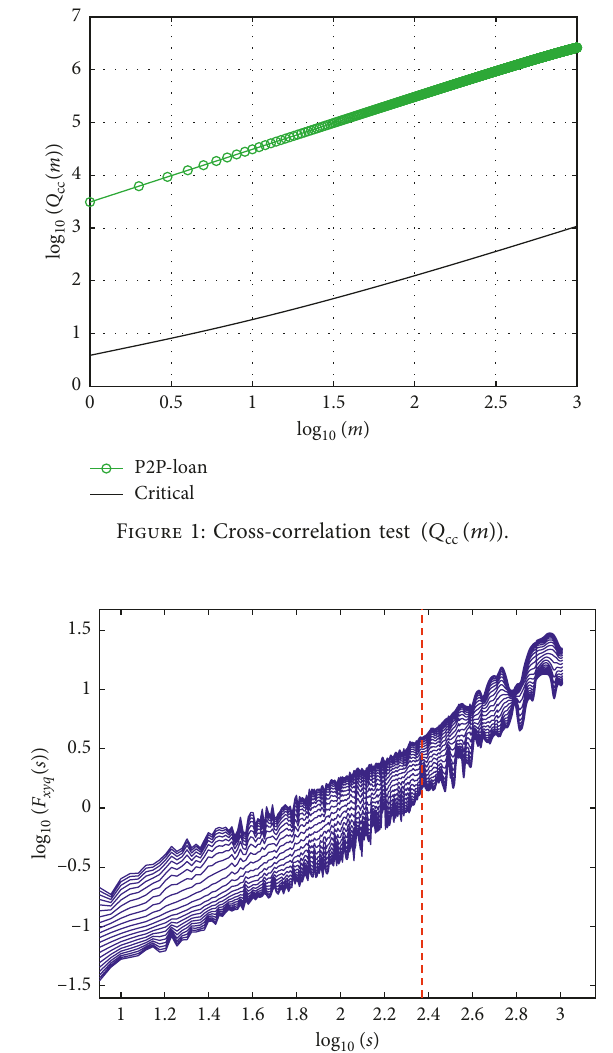
Figure 2: Log-log plots of F